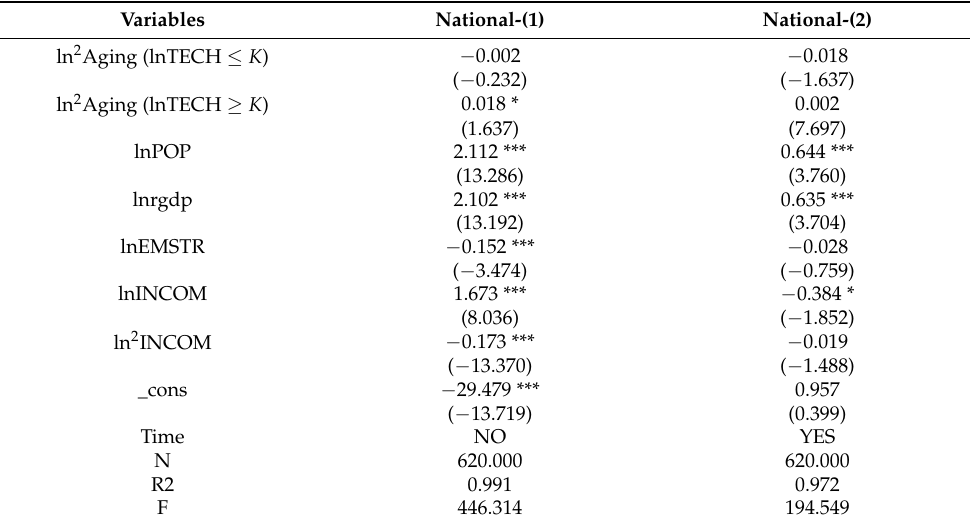
Table 14. Threshold effect of technological innovation level on the impact of the population aging squared term on carbon